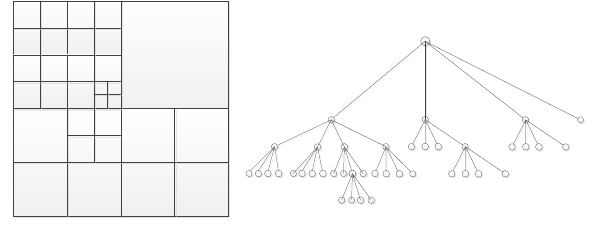
Figure 2 Terrain represented by a quadtree structure